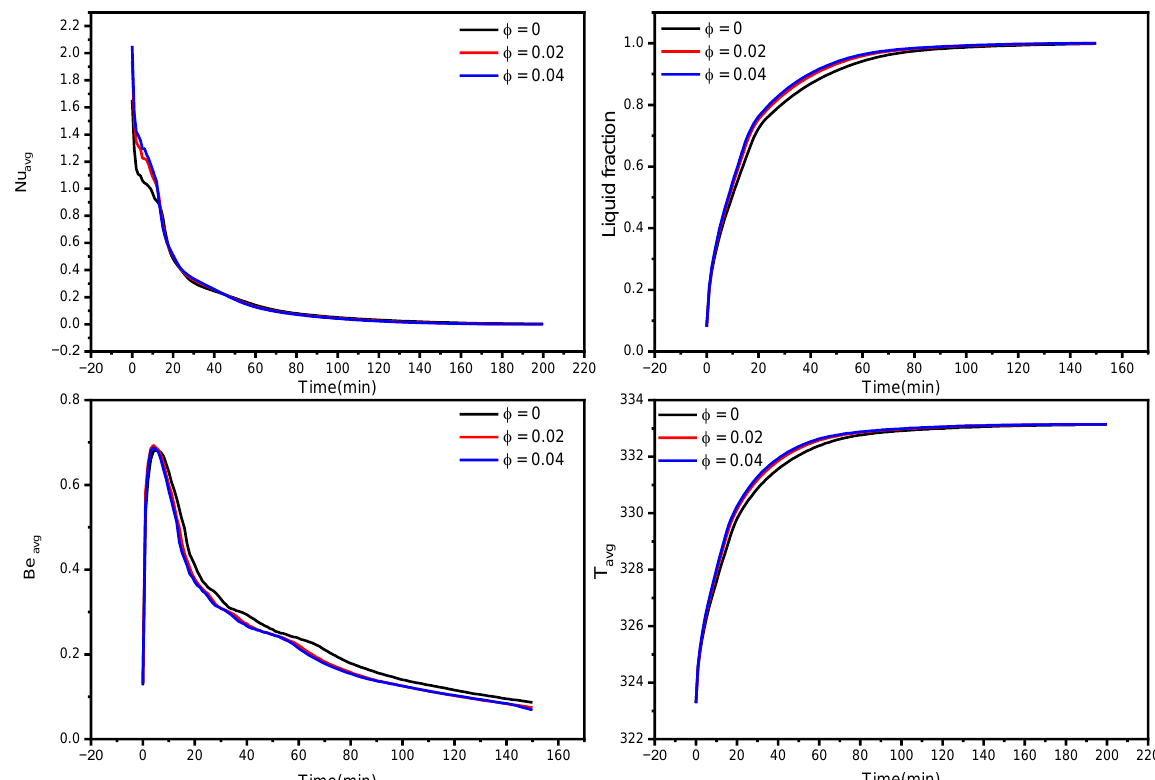
Figure 6. Influence of Copper nanoparticles concentration on average Nusselt number, the average liquid fraction (B), Bejan number, and average temperature during the NePCM melting process.